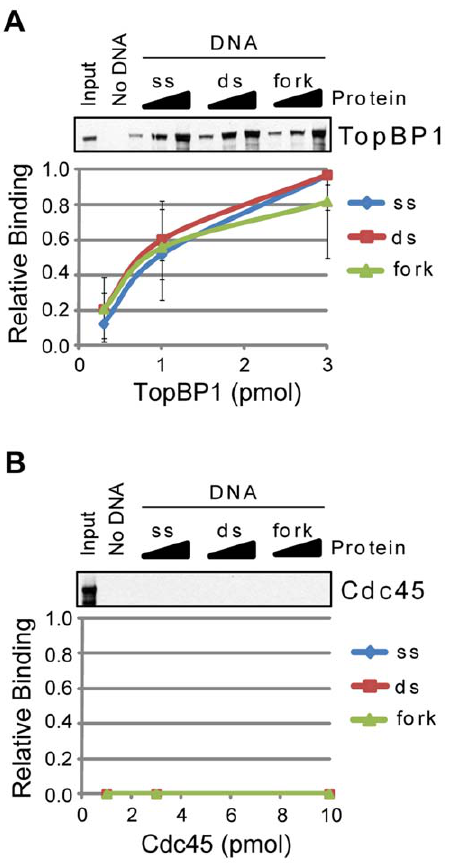
Figure 5. Association of TopBP1 and Cdc45 with DNA. The association of each of the indicated purified proteins with beads alone (No DNA) or to single-stranded (ss), double-stranded (ds), and branched, replication fork-like (fork) DNA bound to magnetic beads was analyzed by SDS-PAGE and immunoblotting. Each of the following proteins was analyzed for binding to each DNA structure: (A) TopBP1 and (B) Cdc45. Reactions were carried out as described in the Methods section.